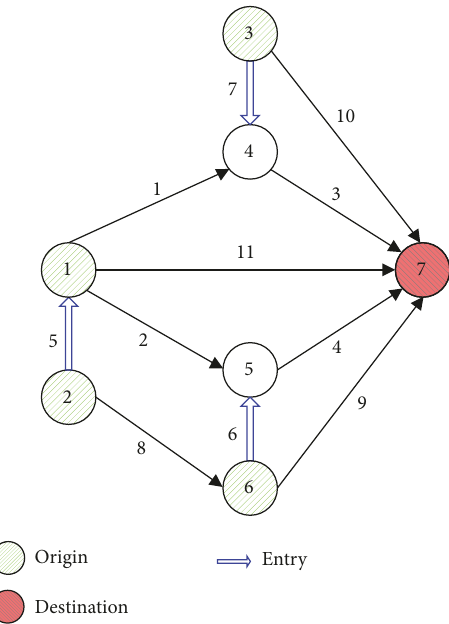
Figure 1: Network structure for the numerical experiment.